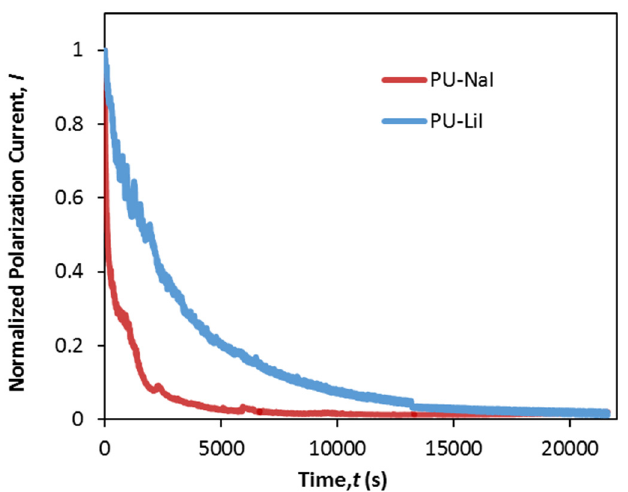
Figure 7. The plots of normalized polarization current with time for PU-LiI and